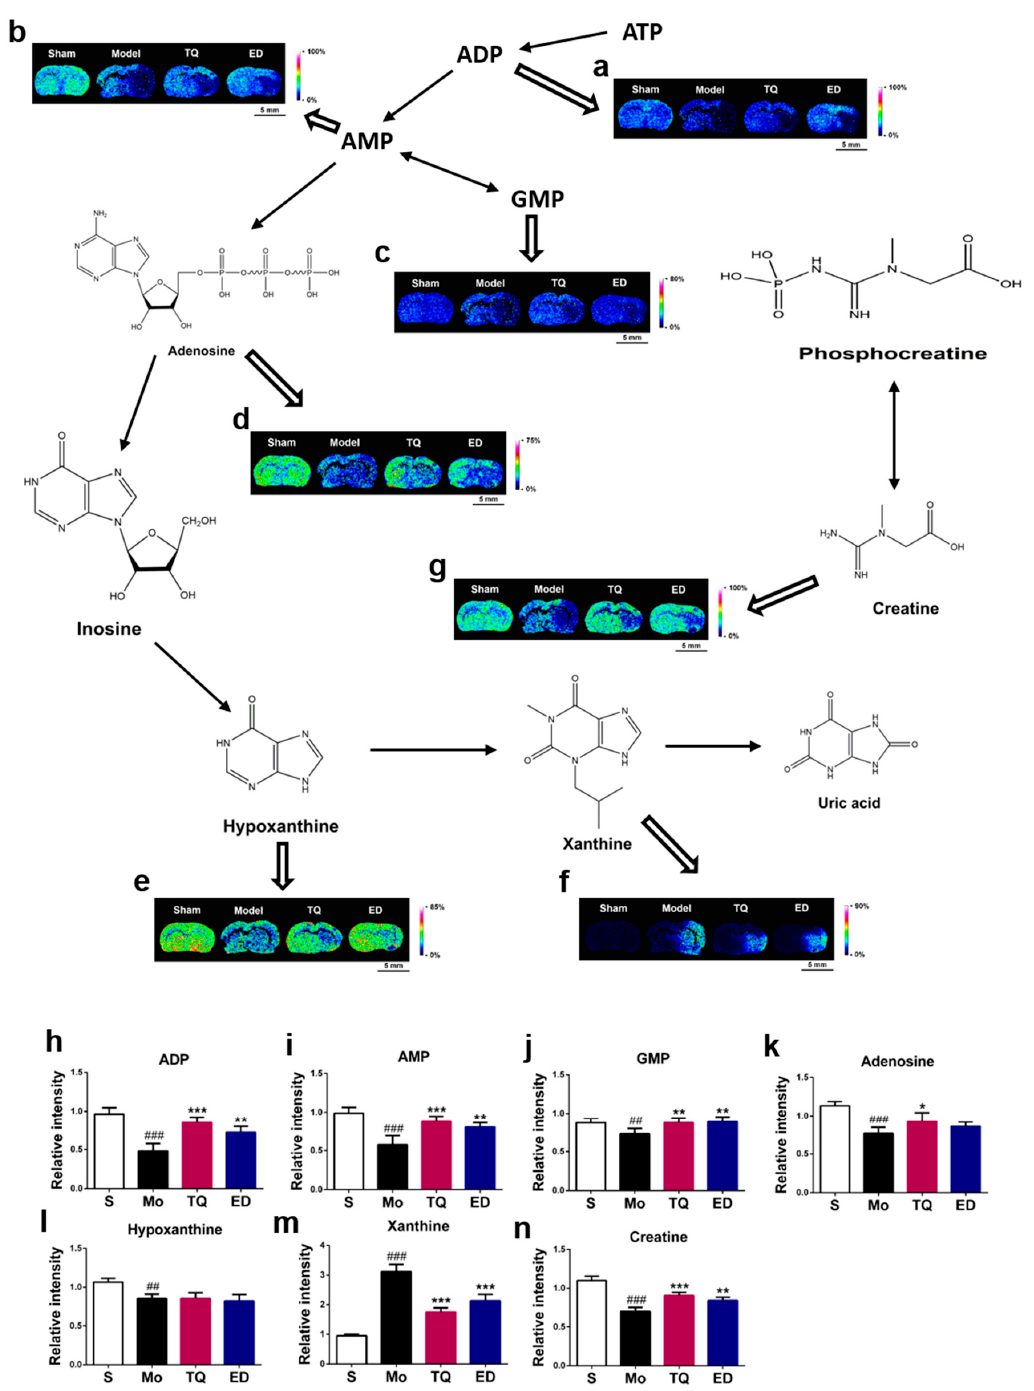
Figure 4. In situ matrix-assisted laser desorption ionization mass spectrometry imaging (MALDI-MSI) distribution and changes in energy metabolism-related small molecules. ( a – g ) Representative MALDI-MSI images of metabolites, ( h – n ) statistical results of the relative changes in metabolites, with the relative intensity of each metabolite calculated by the average intensity ratio of the ischemic hemisphere to the contralateral hemisphere. ( a , h ) ADP, ( b , i ) AMP, ( c , j ) GMP, ( d , k ) Adenosine, ( e , l ) Hypoxanthine, ( f , m ) Xanthine, ( g , n ) Creatine. The spatial resolution of MALDI-MSI images is 200 µ m, and the bar scale is 5 mm. Data are expressed as mean ± SD ( n = 4), ## p < 0.01, ### p < 0.001 vs. sham group; * p < 0.05, ** p < 0.01, *** p < 0.001 vs. model group. S: Sham; Mo: Model; TQ: 5 mg / kg thymoquinone; ED: 3 mg / kg